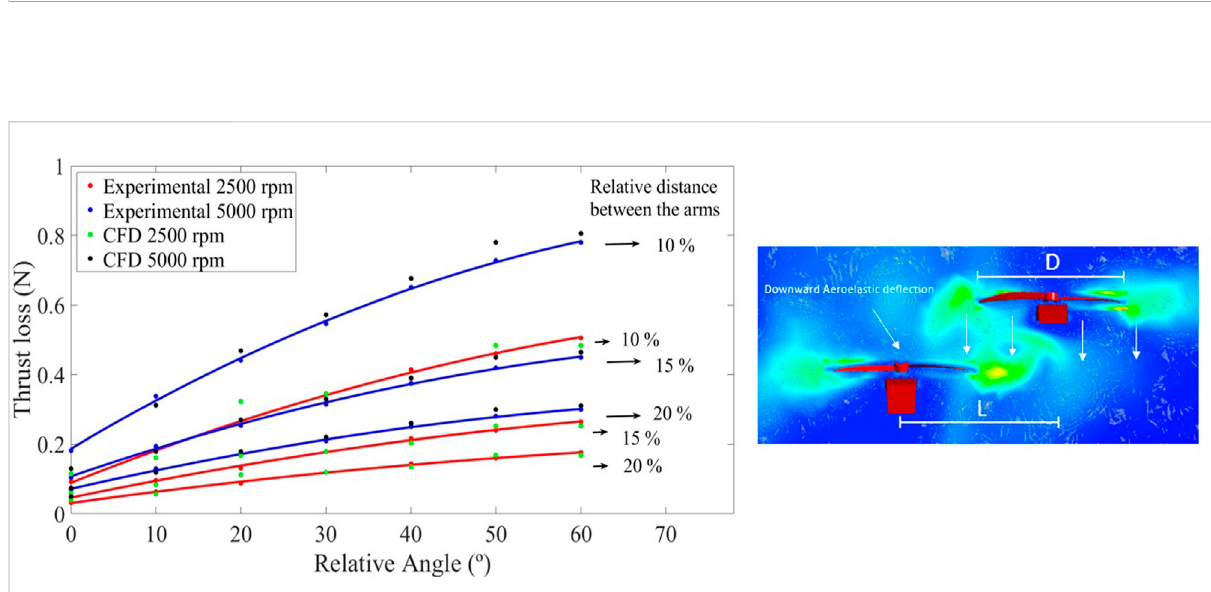
FIGURE 3 Left fi gure shows an analysis of the thrust loss in the lower arm due to aerodynamic interactions at 5000 rpm (blue curves) and 2500 rpm (red curves) by means of CFD (green and black dots) and experimental results (red and blue dots) for different distances and relative angles between the arms. In the right fi gure, pressure distributions in the vicinity of the arms are